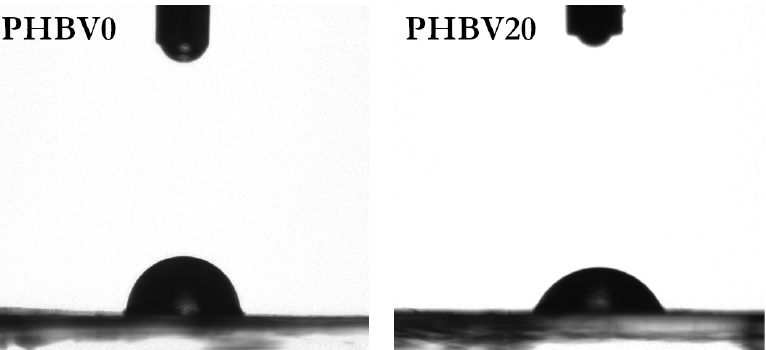
Figure 6. Optical contact angle images of water on the untreated film surface (PHBV0) and the LiBH 4 ‐ treated one (PHBV20).